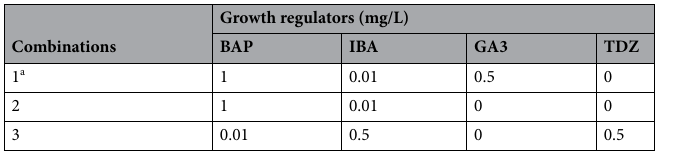
Table 1. The MS, WPM, QL media with growth regulator combinations for almond explants proliferation. a This combination was also investigated with the temporary immersion bioreactor system.